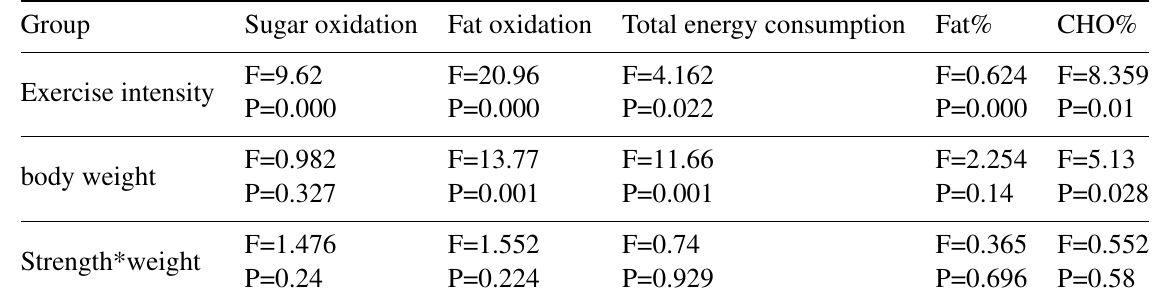
Table 6 Two-factor analysis of variance results of the effects of exercise intensity and body weight on substrate metabolism and energy expenditure during the recovery period after